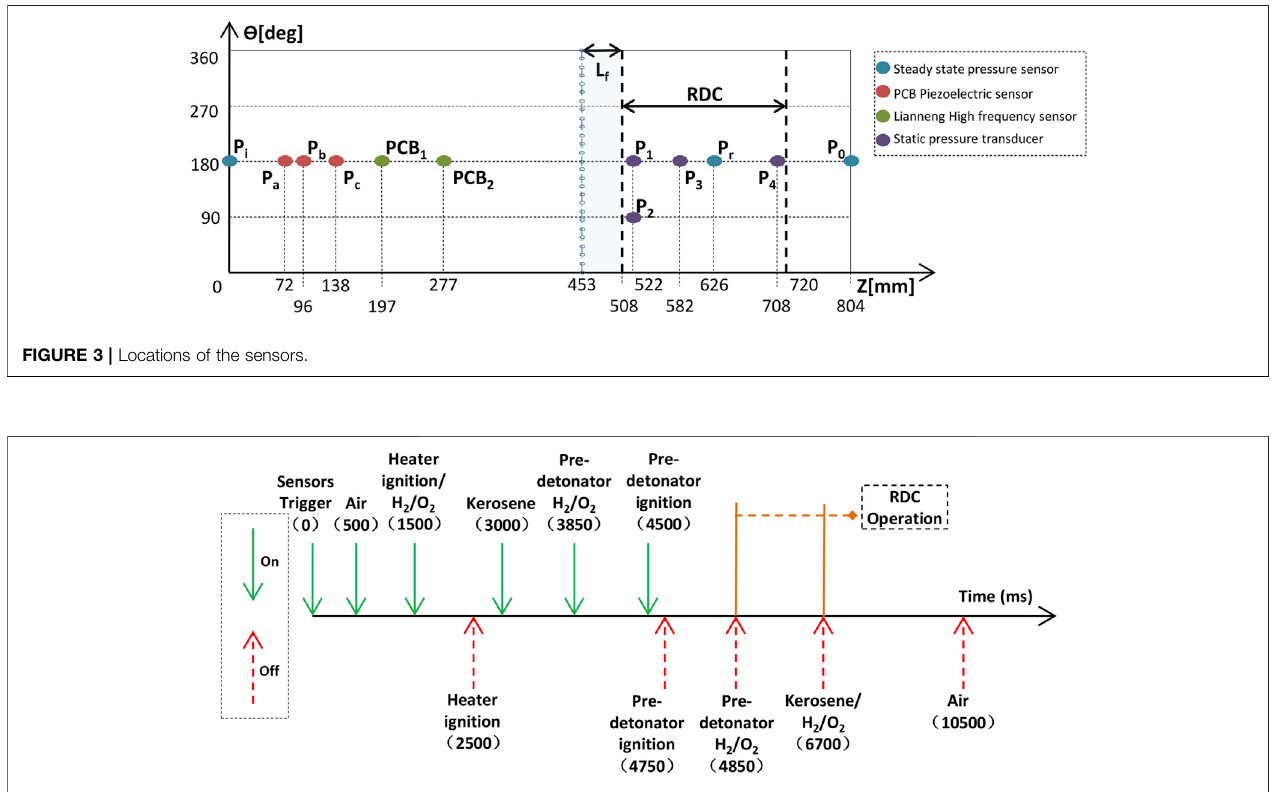
FIGURE 4 | Time sequence of the experimental